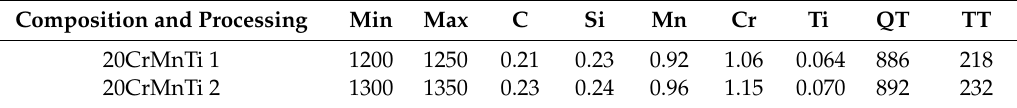
Table 8. Characteristic elements corresponding to the tensile strength output